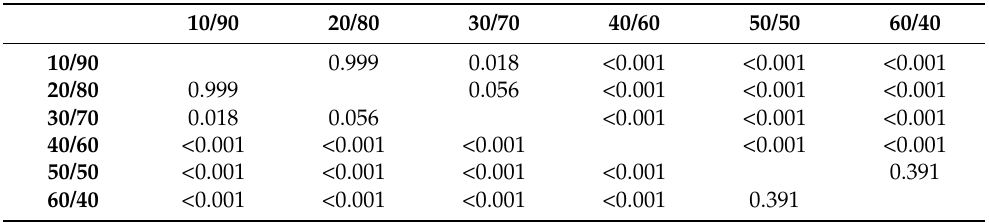
Table 2. p -values relative to Tukey’s post hoc comparisons between the offers and the acceptance rate in all the experimental